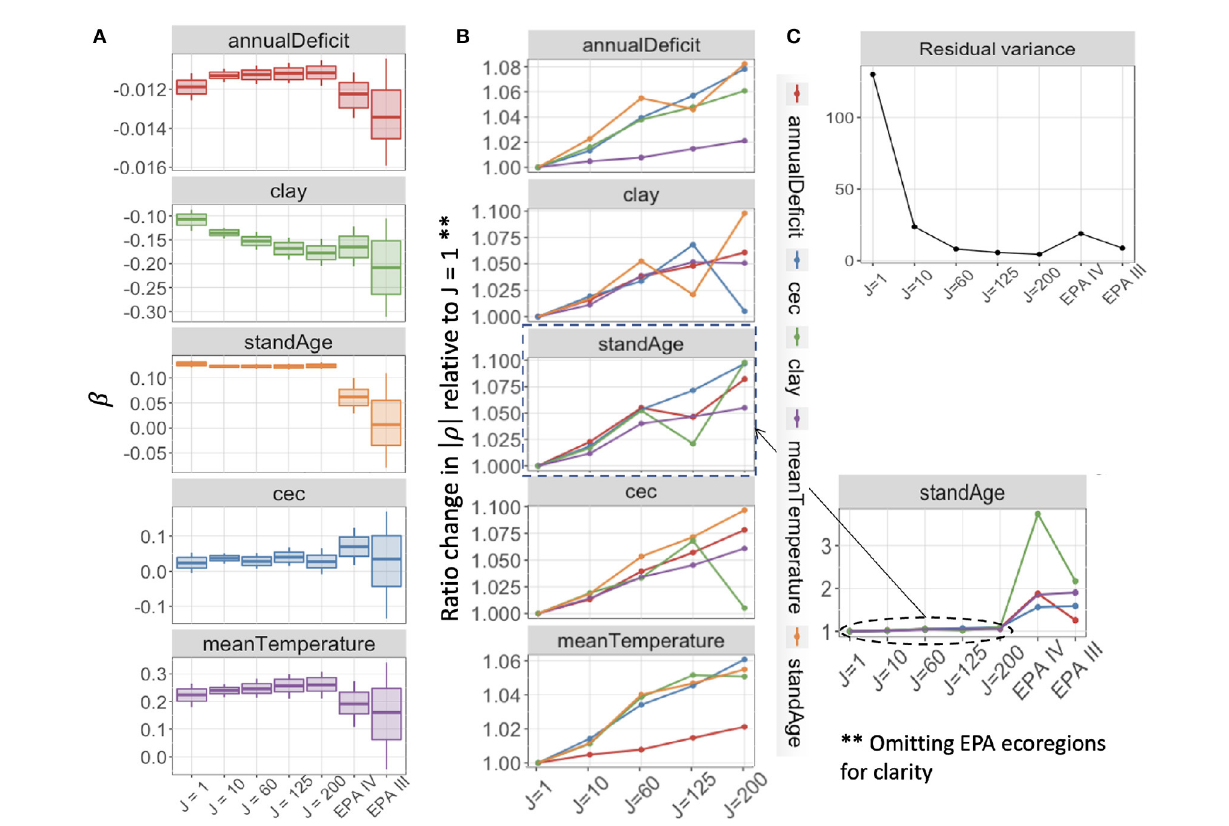
FIGURE5 (A) Posterior mean estimates, with 68 and 95% credible intervals for coefficients in the Gaussian model for basal area with aggregation of FIA plots. Credible interval width shows modest increase with aggregation level from aggregations of J = 10 up to J = 200 plots, and large uncertainty at ecoregions (EPA III, IV). (B) Ratio change from J = 1 in magnitude of pairwise correlations between predictors in X increase slightly with aggregation by distance and covariate similarity ( J = 1, ... ,200) and then increase more dramatically at the ecoregion level (side panel). Colors in (B) denote the second variable that is pairwise correlated with each panel. (C) Estimated residual variance of each model decreases with J , with a large decrease from J = 1 to J = 10.